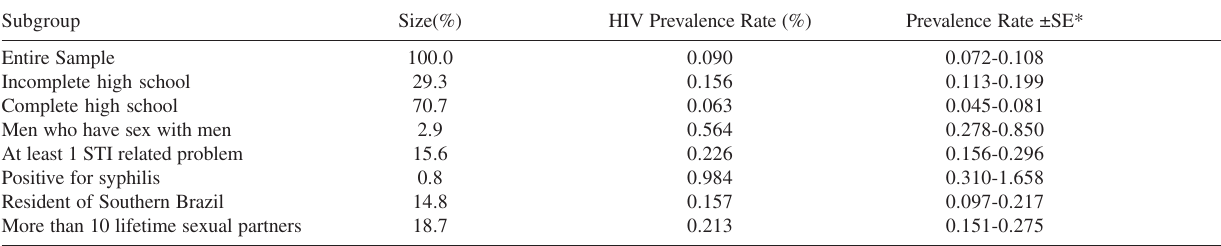
Table 5 - HIV infection prevalence rate in selected subgroups. Brazilian Army conscripts, 2002 Subgroup Size(%)